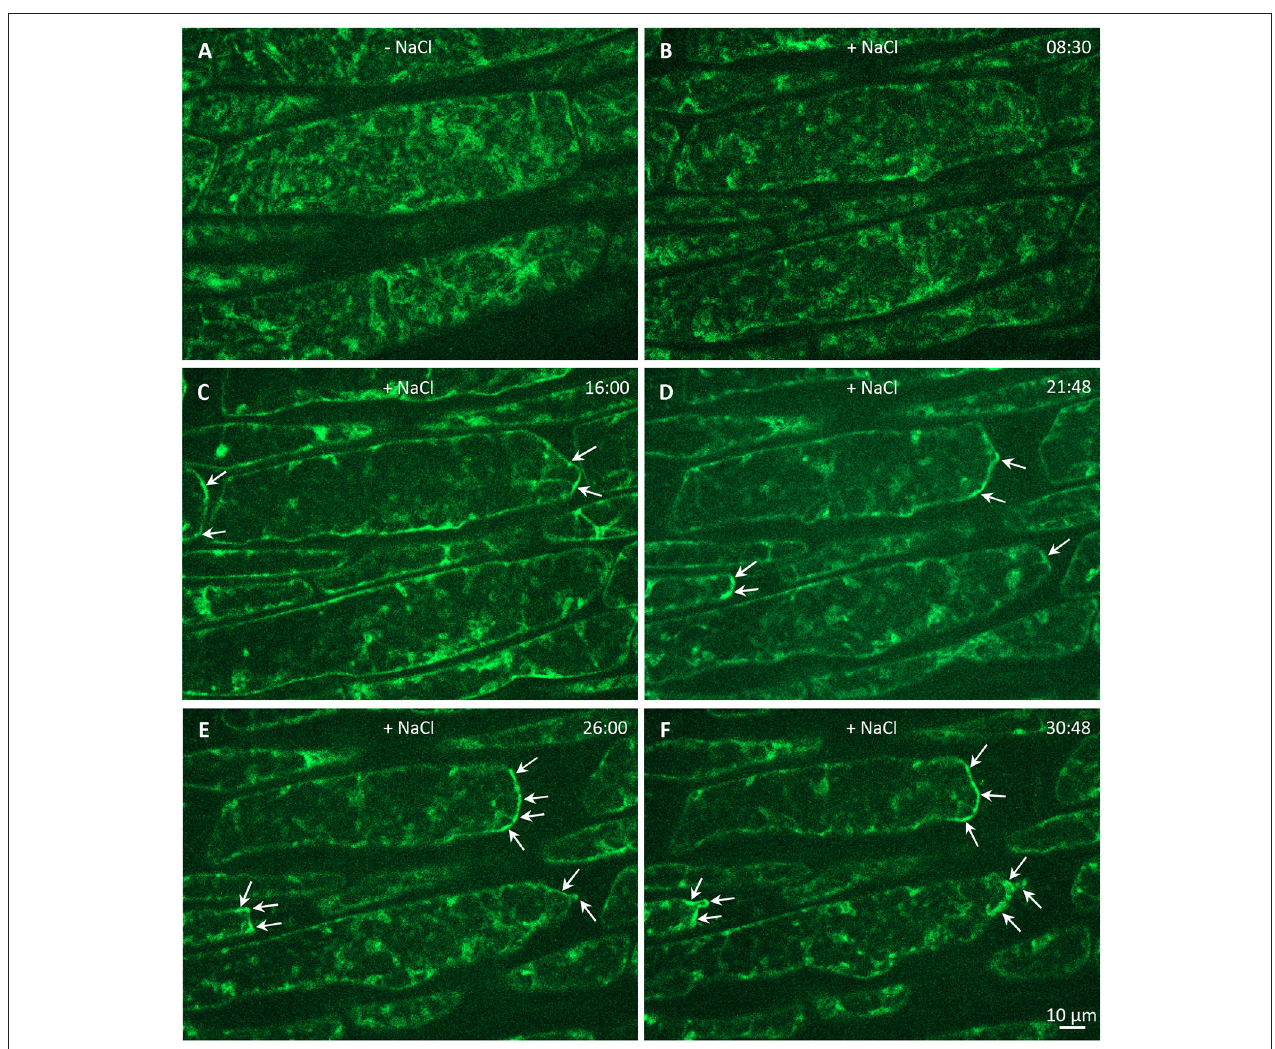
FIGURE 12 | Effect of salt stress on relocalization of PLD α 1-YFP (shown in artificial green color) driven by its native promoter in hypocotyl epidermal cells of complemented pld α 1-2 mutant. (A) Time-lapse imaging of PLD α 1-YFP in hypocotyl epidermal cells under control conditions without salt and (B–F) during plasmolysis induced by 500mM NaCl. The dynamic relocation and accumulation of PLD α 1-YFP in plasmolyzed surface areas of detaching protoplasts is depicted by arrows. Time is indicated in